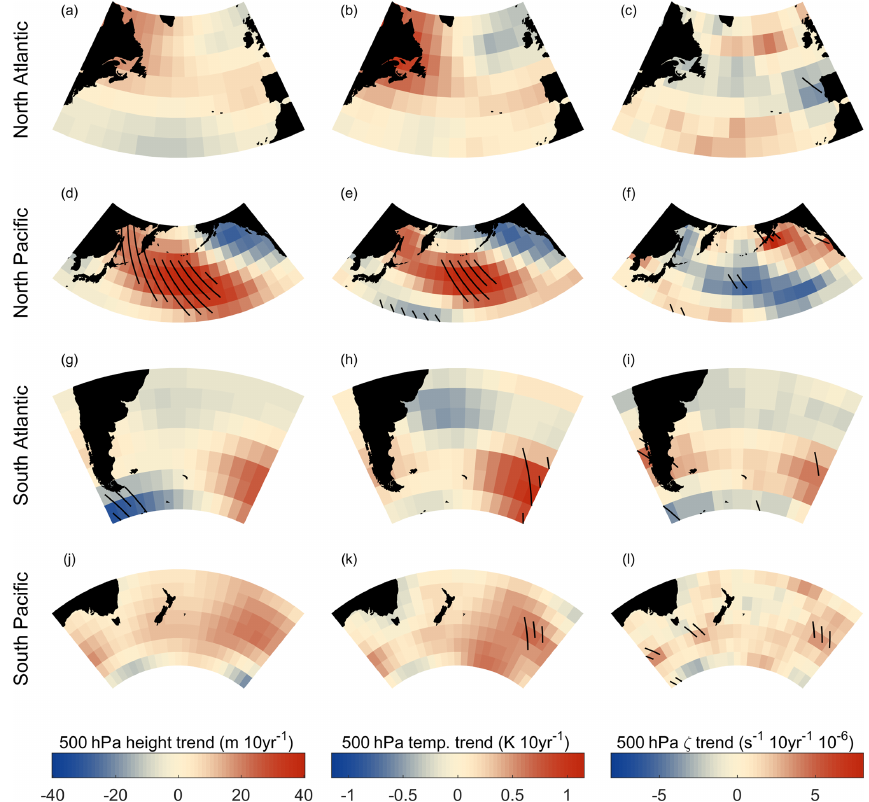
Figure 2. Trends between 2000 and 2013 in ERA-Interim 500hPa geopotential height, temperature, and absolute vorticity in each of the extratropical study regions: North Atlantic (25–65 ◦ N, 280–360 ◦ E), North Pacific (25–65 ◦ N, 120–240 ◦ E), South Atlantic (25–65 ◦ S, 280– 360 ◦ E), and South Pacific (25–65 ◦ S, 120–240 ◦ E). Hatching denotes trends that pass a 95% confidence test. The North Pacific region shows significantly increased heights (d) , temperature (e) , and anti-cyclonic flow (f) (negative trends in absolute vorticity in the Northern Hemisphere) primarily in the storm track regions and extending into the subtropics. All of these features are commonly associated with ex- tratropical high-pressure systems. Both of the Southern Hemisphere study regions show similar increases in heights (g, j) , temperature (h, k) , and anti-cyclonic flow (i, j) in the storm track regions as well; however, only small areas in the center of the locations with positive trends pass the significance test. The North Atlantic study region (a–c) shows no trends that are significant at the 95%